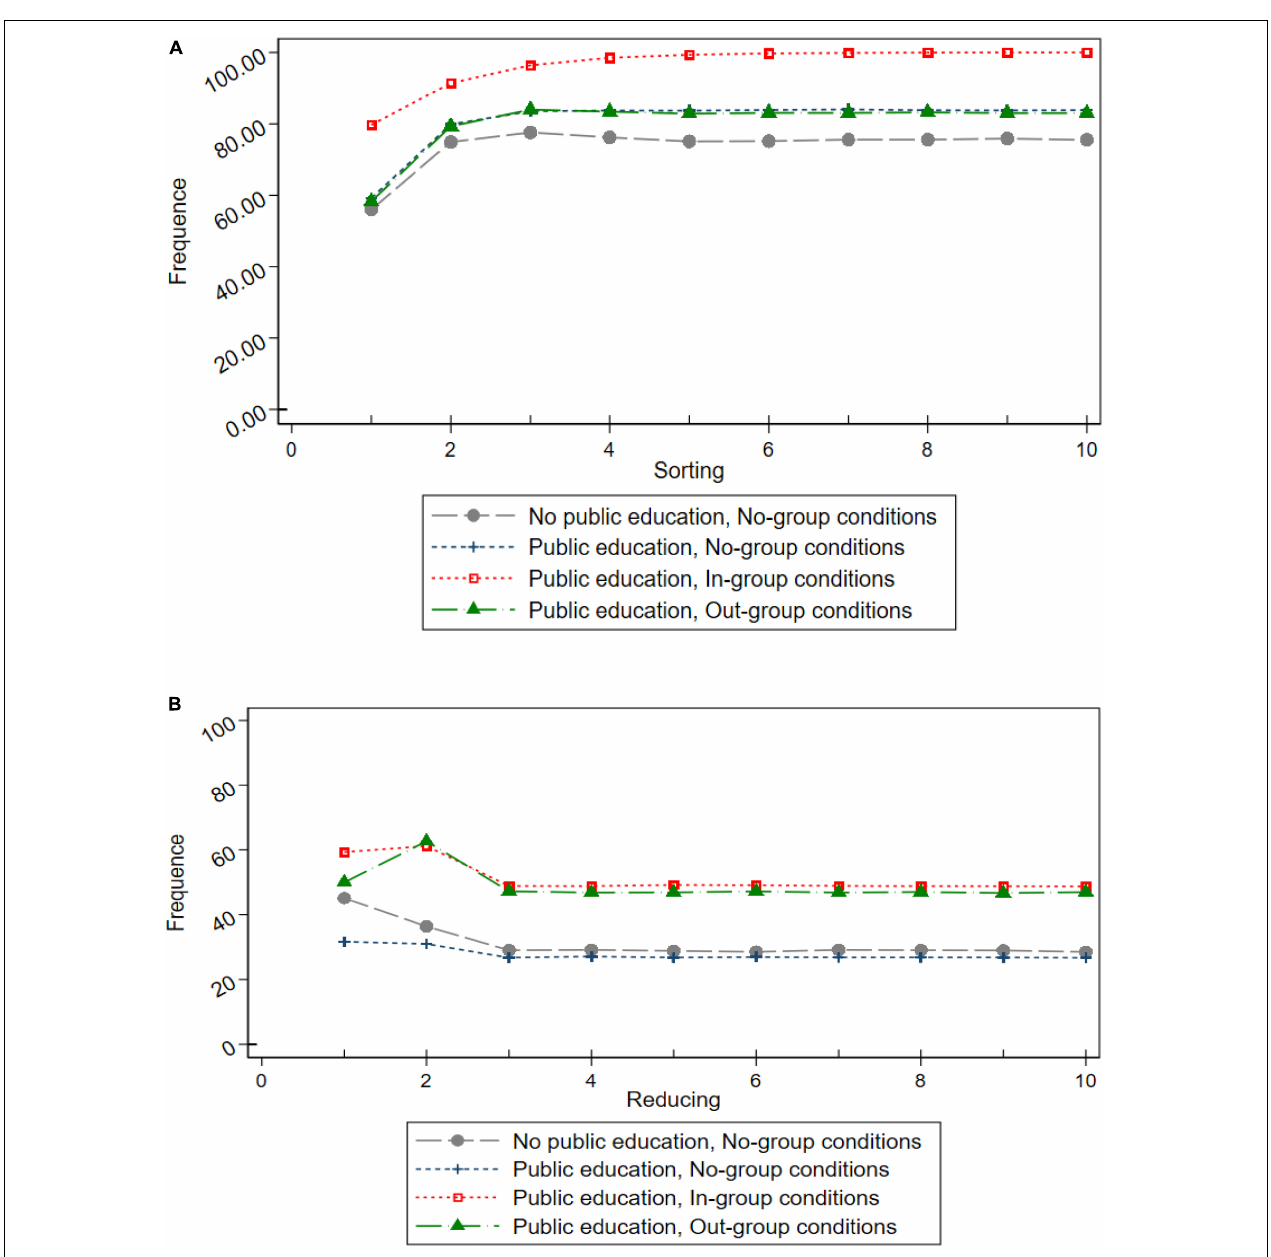
FIGURE 1 | The trend of the probability distribution of pro-environmental behaviors (PEBs). (A) sorting (simulations). (B) Reducing (simulations).